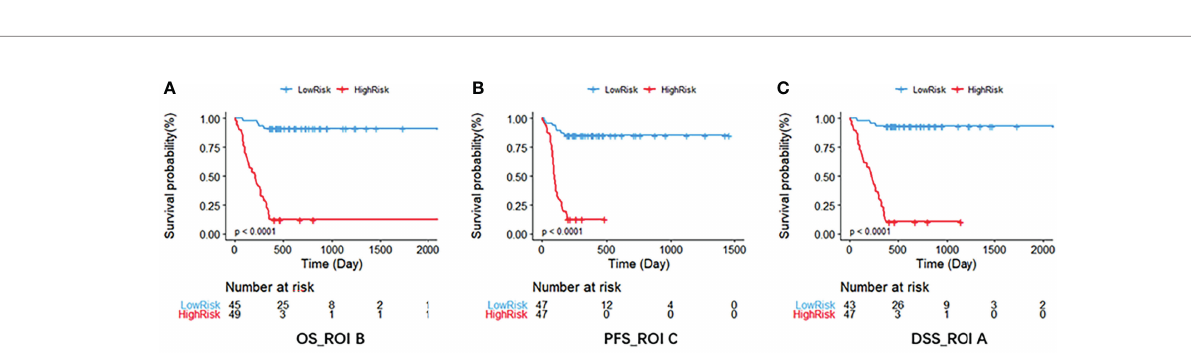
FIGURE 7 | The Kaplan – Meier survival curve shows OS (A) , PFS (B) , and DSS (C) risk strati fi cation for patients with the optimal models in the validation dataset. Patients were classi fi ed as low risk and high risk according to radiomics signature. DSS, disease-speci fi c survival; OS, overall survival; PFS, progression-free survival; ROI, region of